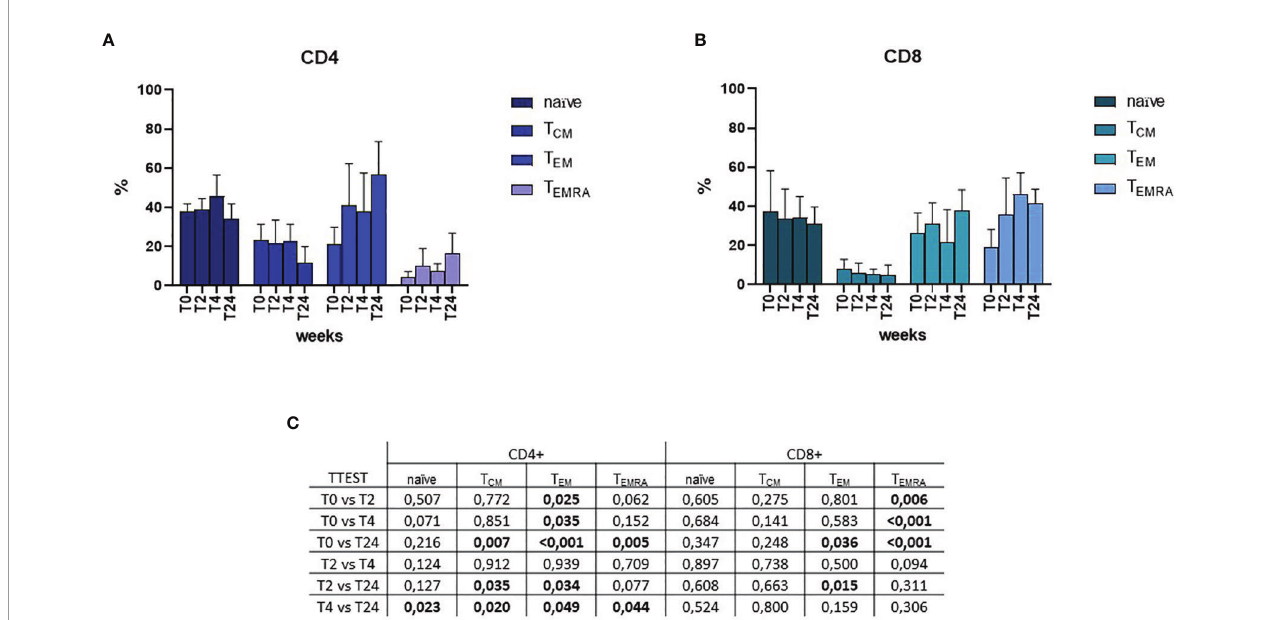
FIGURE 2 | Flow cytometric analyses of memory subsets at T0, T2, T4 and T24 upon SARS-CoV-2 speci fi c in-vitro stimulation of PBMCs. Percentages of naïve, central memory (T CM ), effector memory (T EM ) and effector memory re-expressing CD45RA (T EMRA ) T helper CD4+ and T cytotoxic CD8+ are depicted in (A, B) , respectively. Mixed-effects model (REML) analysis showed a statistical signi fi cance of p =0.006 for the time effect on CD4+ cells, and p =0.058 for CD8+. Statistical signi fi cance obtained by multiple t Test analyses is reported in (C) . p ≤ 0.05 values are highlighted in